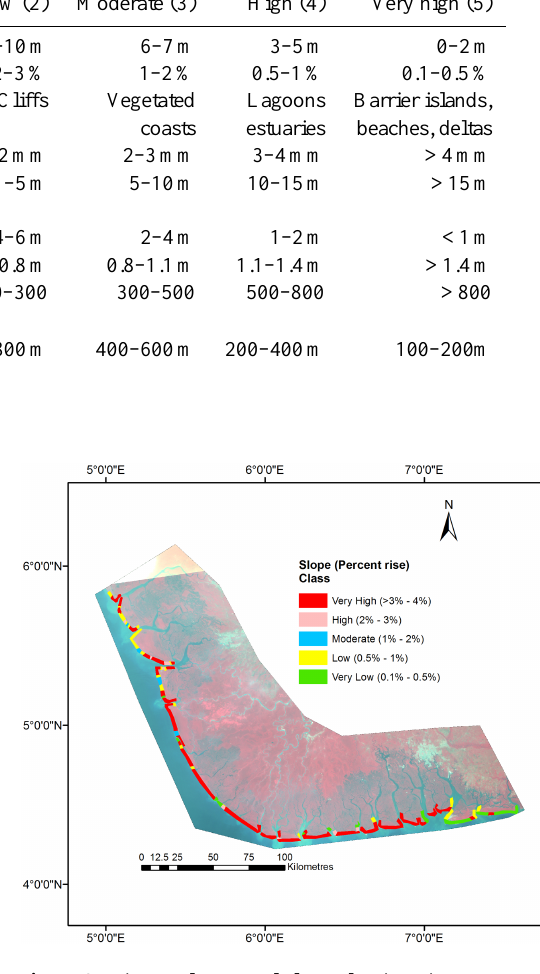
Figure 3. Niger Delta coastal slope